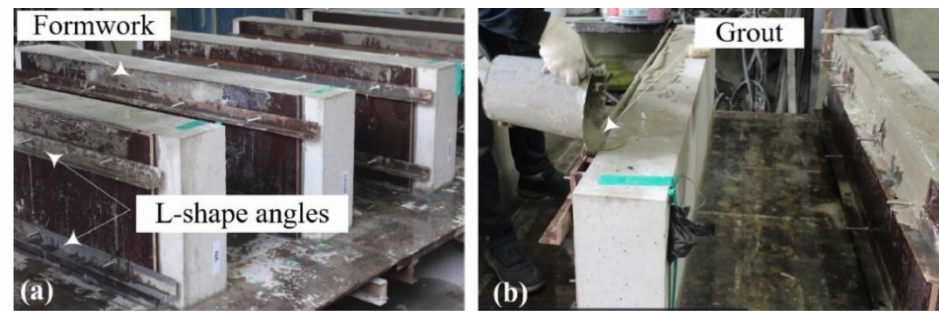
Figure 9. Schematics of a grid anchor system.